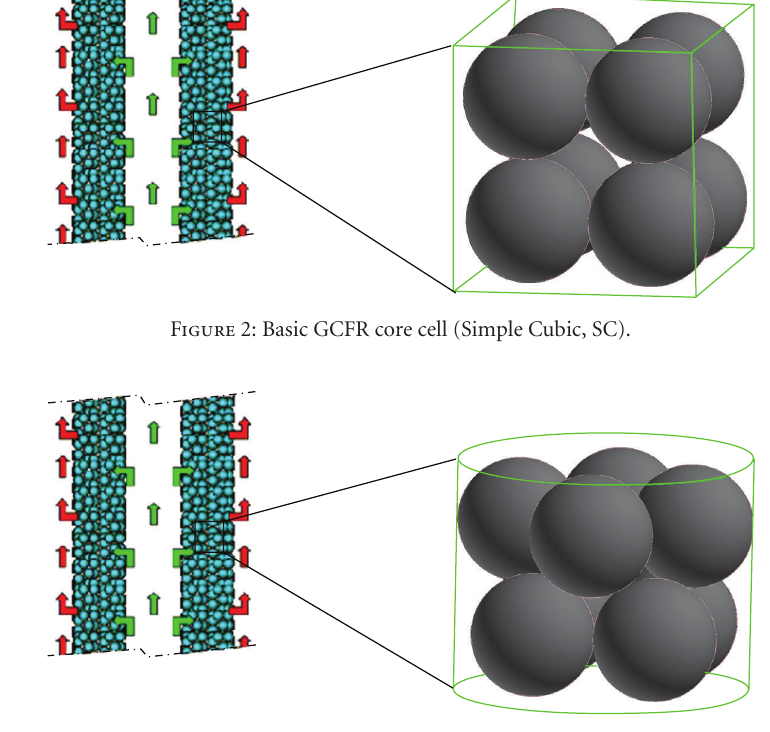
Figure 3: Basic GCFR core cell (Face-Centred Cubic, FCC).